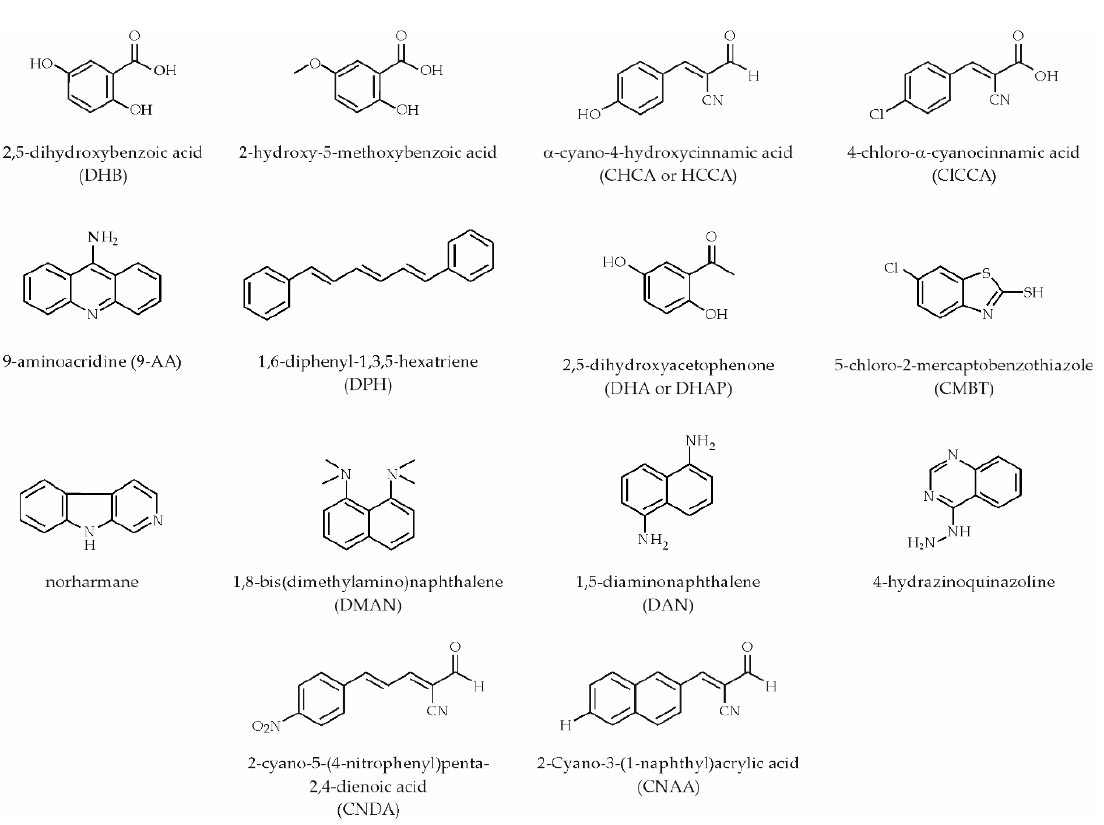
Figure 1. Survey of the organic MALDI matrices, which are discussed in this review. It is important to note that these are (in our opinion) just the most important matrices in the lipid field. For specific questions and certain analytes, the application of different matrices may be beneficial.